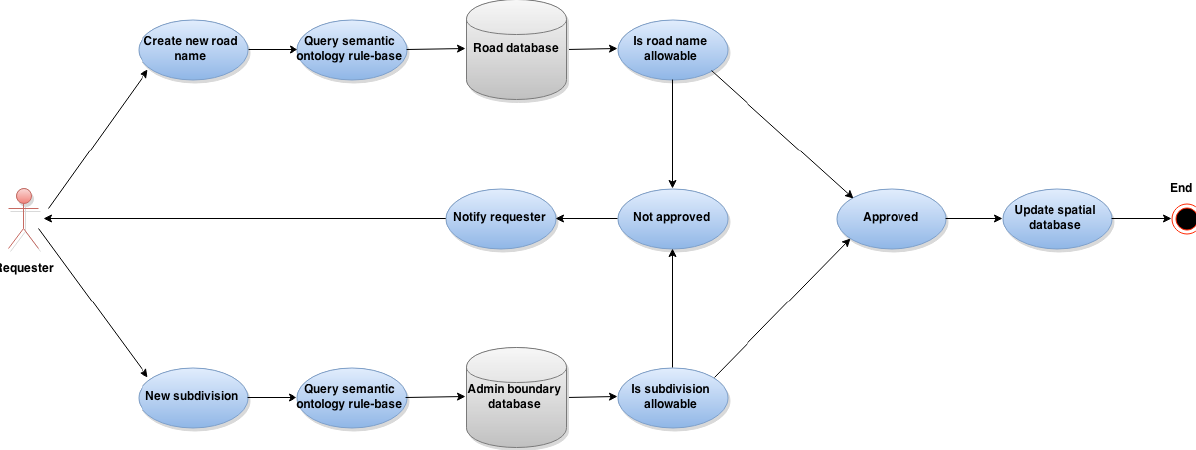
Figure 2. Geospatial Transaction